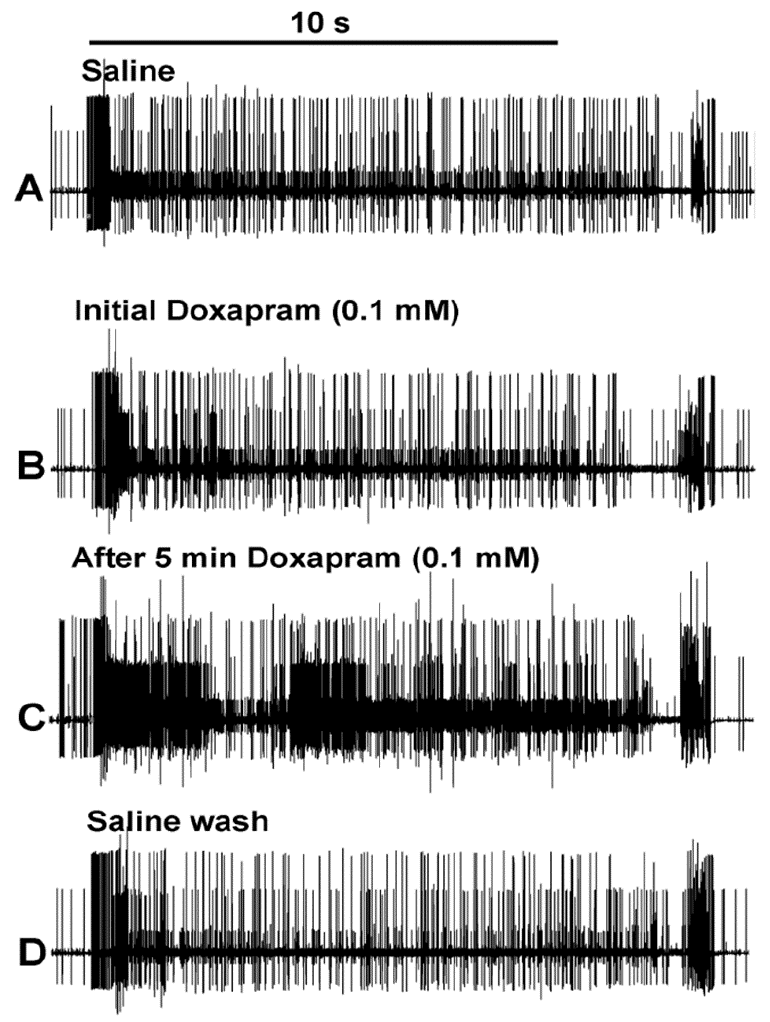
Figure 4. Representative responses to the effects of 0.1 doxapram exposure. The second trial of the three movements for each condition: ( A ) initial saline, ( B ) initial exposure to doxapram, ( C ) 5 min of incubation to doxapram, and ( D ) saline wash out. The number of spikes within the initial 10 s is used for quantification.